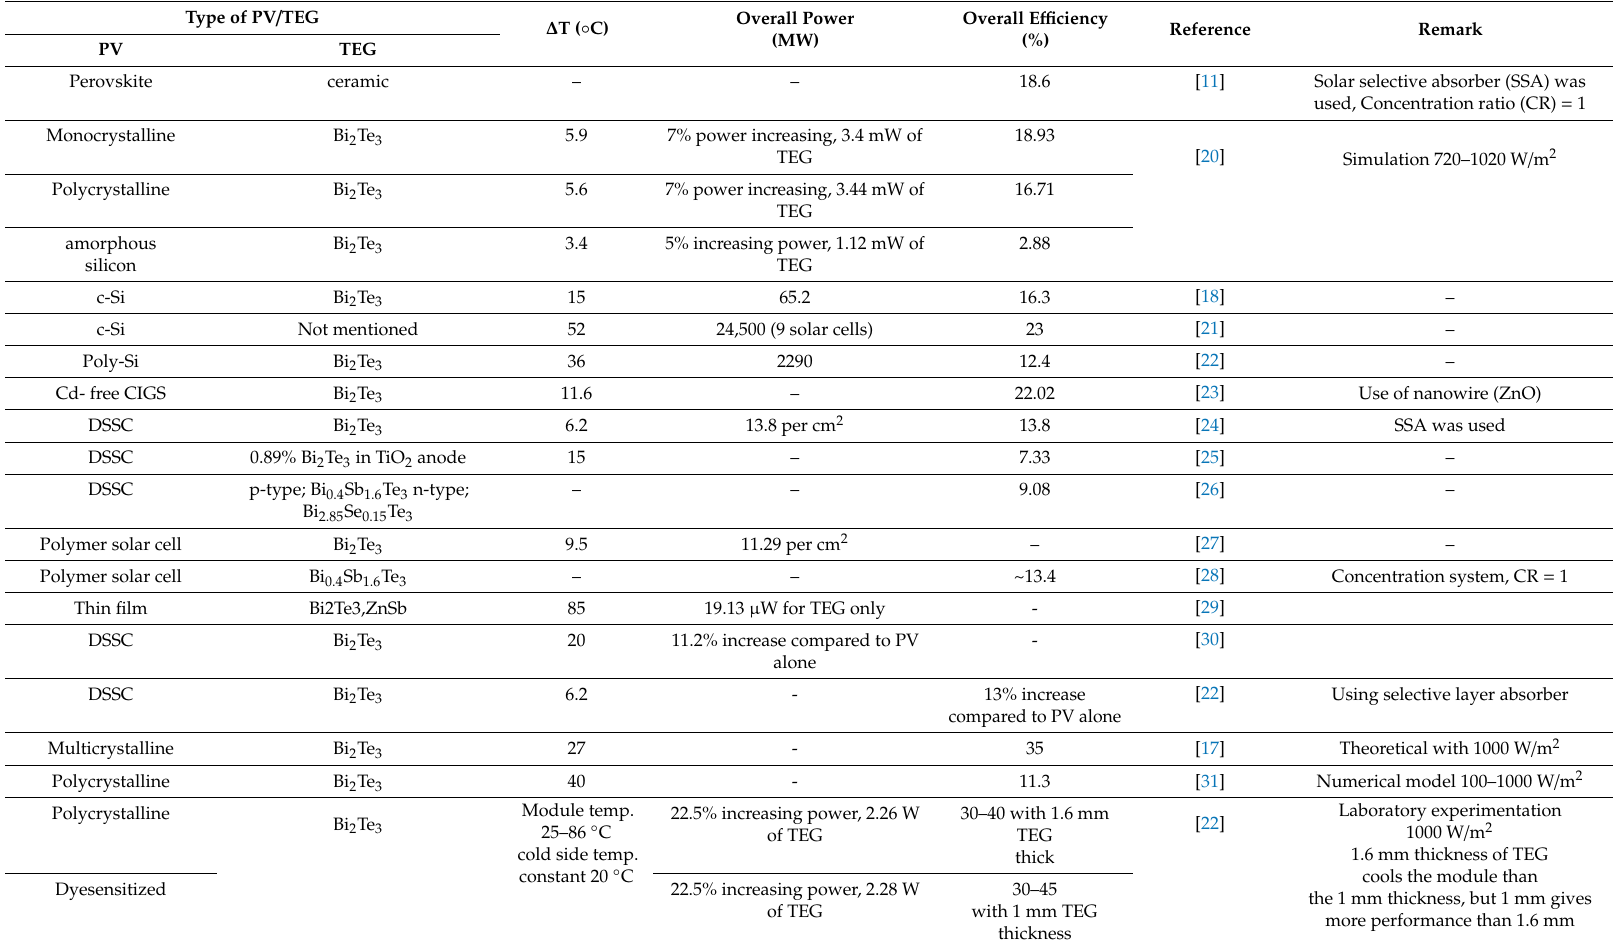
Table 1. The overall performances of di ff erent PV / TEG